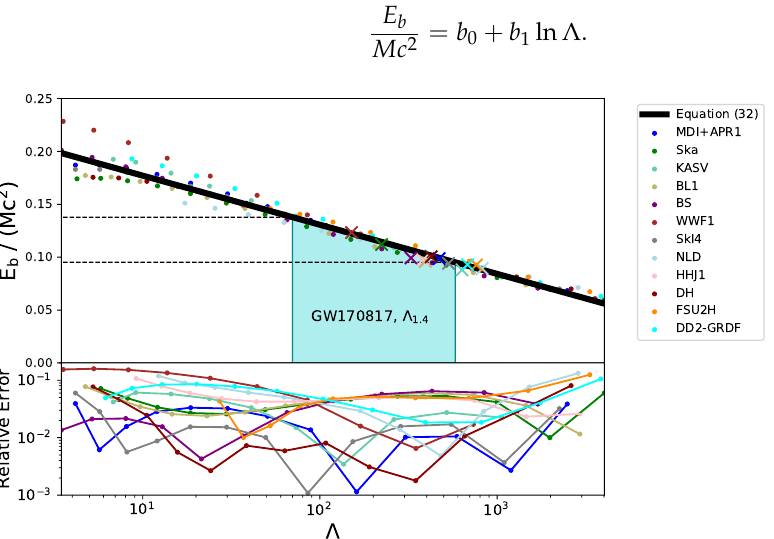
Figure 6. Top panel: Relation between the dimensionless tidal deformability and the star’s binding energy for cold neutron stars and linear fitting. The circular points correspond to cold EOS. The solid line stands for the fit of Equation (32), which was performed for cold EOSs, in the mass range M ∈ [ 1 M (cid:12) , M max ] . The cross points represent the 1.4 M (cid:12) configuration for each EOS. The shaded area shows the upper and lower values of the dimensionless tidal deformability ( Λ 1.4 = 190 + 390 − 1.4 M (cid:12) neutron star from the analysis of the GW170817 event [37]. Bottom panel: Relative error for the fit of Equation